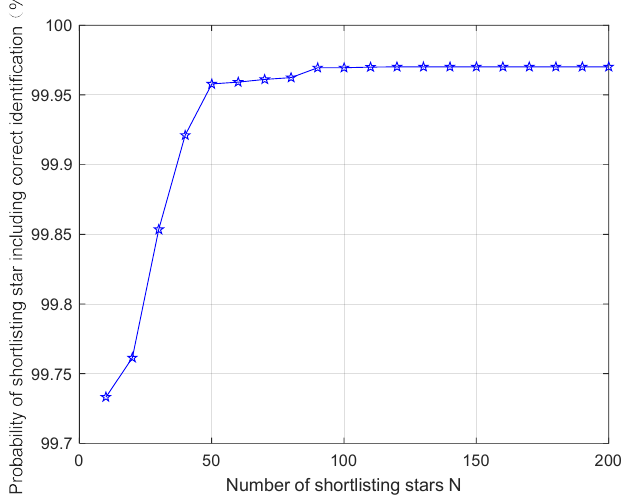
Figure 13. Probability of shortlisting stars with correct identifications under different numbers of shortlisted stars N .